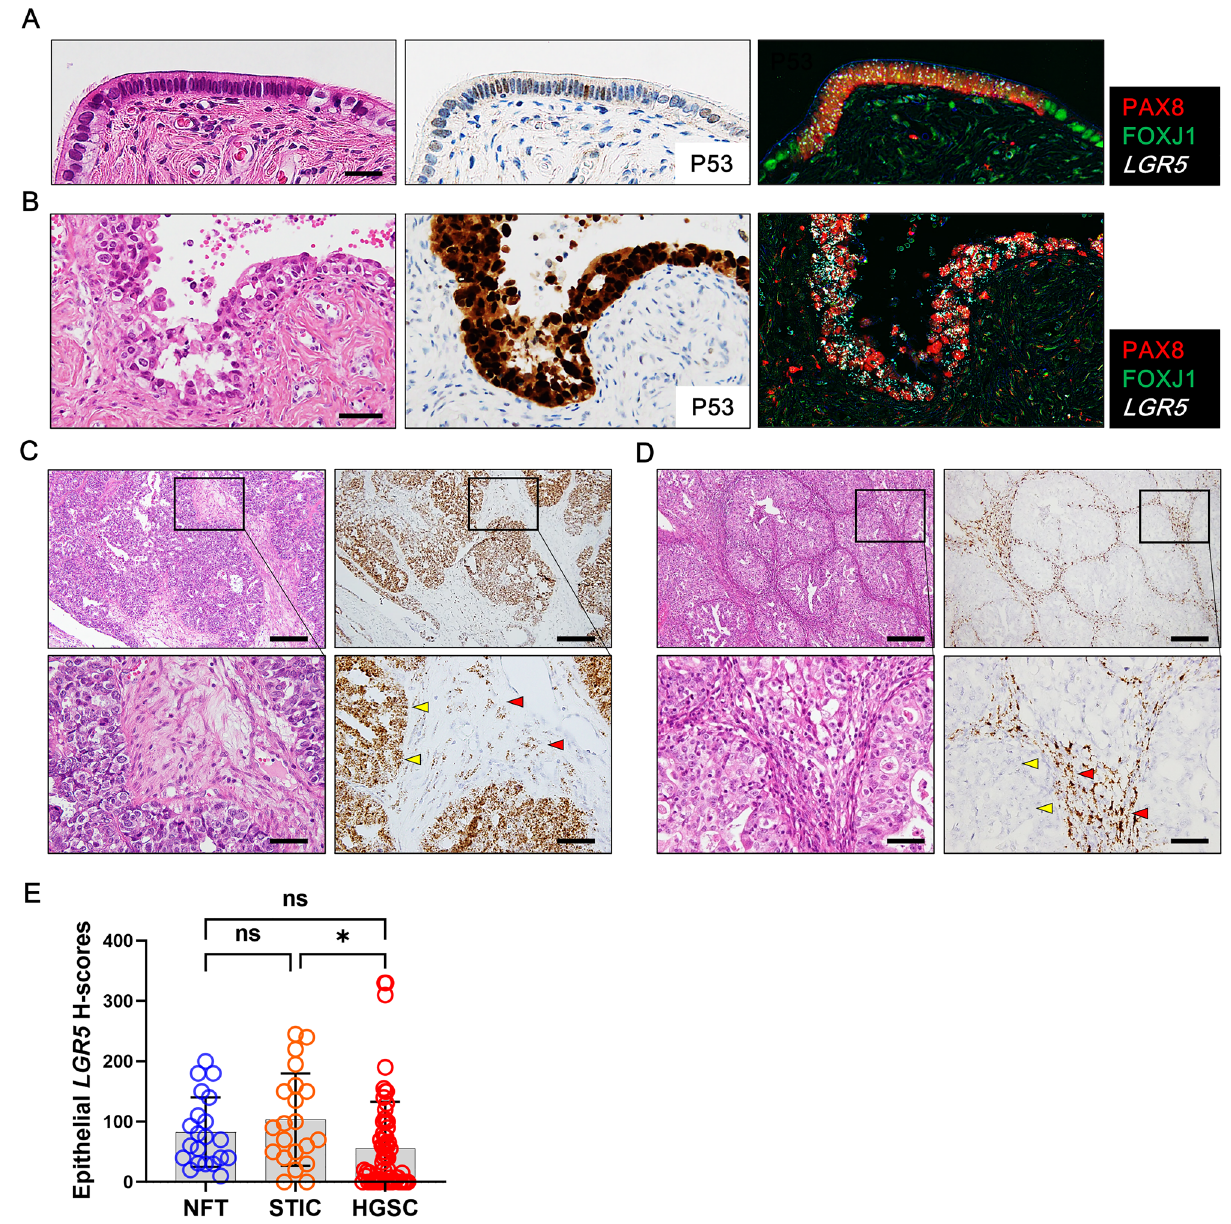
Figure 5. LGR5 expression in secretory cell outgrowth (SCOUT), serous tubal intraepithelial carcinoma (STIC) and high-grade serous carcinoma (HGSC). Combined in situ hybridization for LGR5 and immunohistochemistry for PAX8 and FOXJ1 shows increased LGR5 expression in the SCOUT ( A ) and STIC ( B ) lesions in which PAX8-positive cells proliferate. ( C ) Representative images of LGR5 expression in HGSC. LGR5 expression is frequently observed not only in carcinoma cells but also in adjacent stromal cells. Scale bar, 0.5 mm (upper panels) and 50 µm (lower panels). ( D ) In some cases, LGR5 expression is only detected in stromal cells. Scale bar, 0.5 mm (upper panels) and 50 µm (lower panels). ( E ) A bar graph showing the histo- scores (H-scores) of LGR5 in in the nontumor fallopian tubes (NFTs) adjacent to STIC lesions (n = 21), STIC lesions (n = 21), and HGSC lesions (n = 64). The data are shown as the means ± SD. ns, not significant. * P < 0.05 by Tukey’s multiple comparisons determine the effect of LGR5 on tumor growth, we induced LGR5 expression in OVCAR-3 and SNU-8 cells. We observed significantly reduced proliferation rates in cancer cells transfected with LGR5 compared to those transfected with a control plasmid (Fig. 7B). As AKT or MAPK signaling pathways are often involved in cancer cell survival, we examined the activation of AKT and ERK proteins and found that LGR5 overexpression resulted in the downregulation of AKT and ERK phosphorylation as well as AKT and ERK protein levels (Fig. 7C). Addi- tionally, we examined apoptosis-related molecules. LGR5 overexpression increased BIM expression in OVCAR-3 cells, but not in SNU-8 cells (Fig. 7C). Cleaved PARP and cleaved caspase-3 also increased in LGR5-transfected